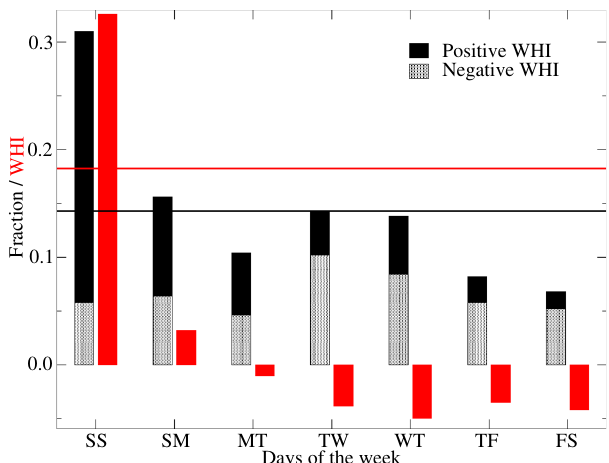
Fig. 2 Histogram of the 1980 – 2019 frequency distribution of low fl ow days and corresponding WHI values. Black bars denote the two consecutive days with low fl ows while red bars represent the WHI values for 500 sites across the USA and Canada, 1980 – 2019. Fractions of the two consecutive days with low fl ows are partitioned according to positive (solid) and negative (dotted) WHI values. The days of the week begin with the Saturday/Sunday (SS) combination and end with the Friday/Saturday (FS) combination. The horizontal black line denotes the expected value if the two-day low fl ows were distributed randomly while the horizontal red line marks the mean WHI across the 500 sites.